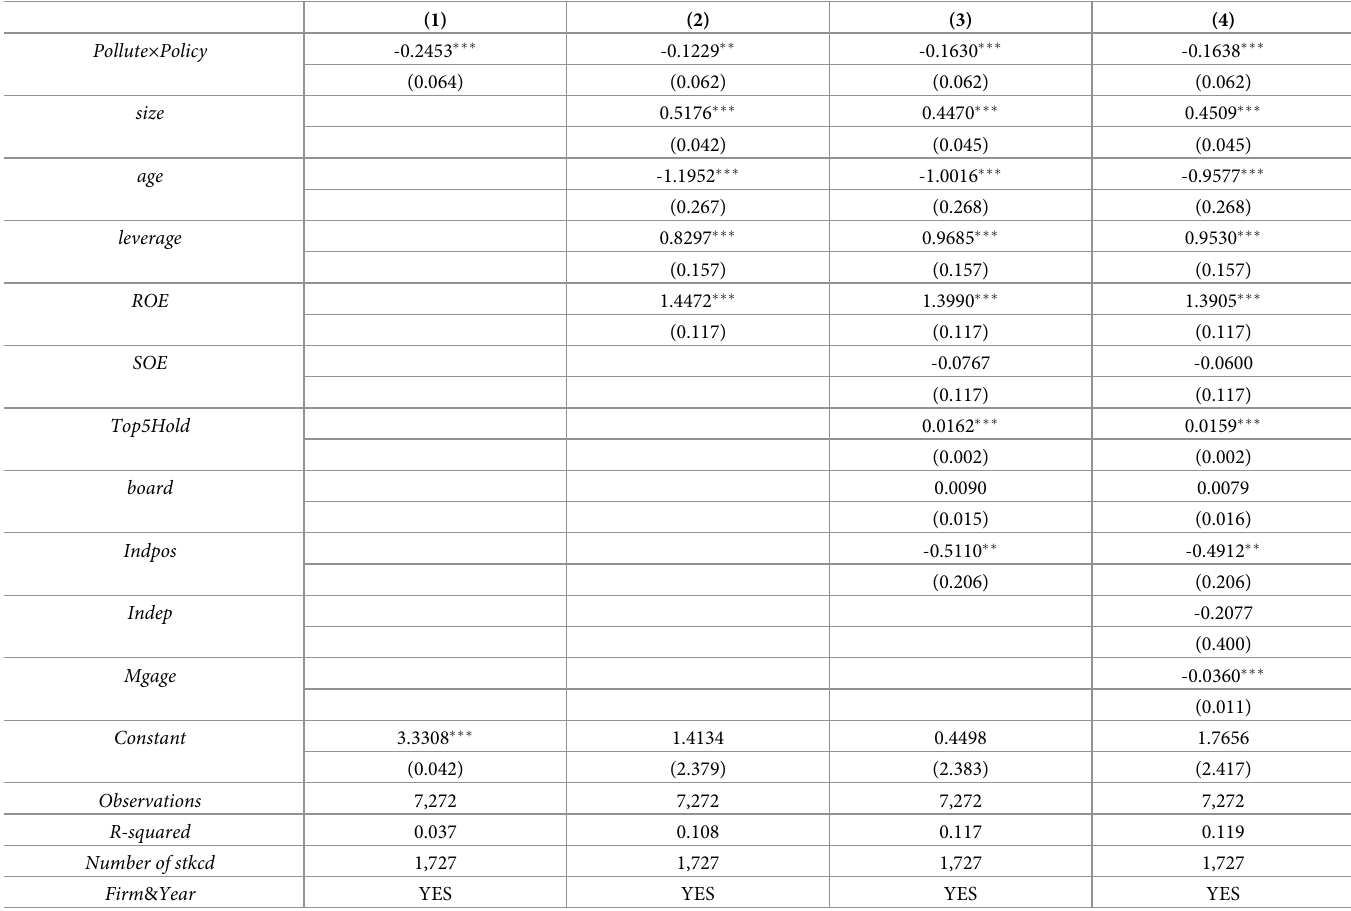
Table 4. Green Credit Guide and enterprise market expansion